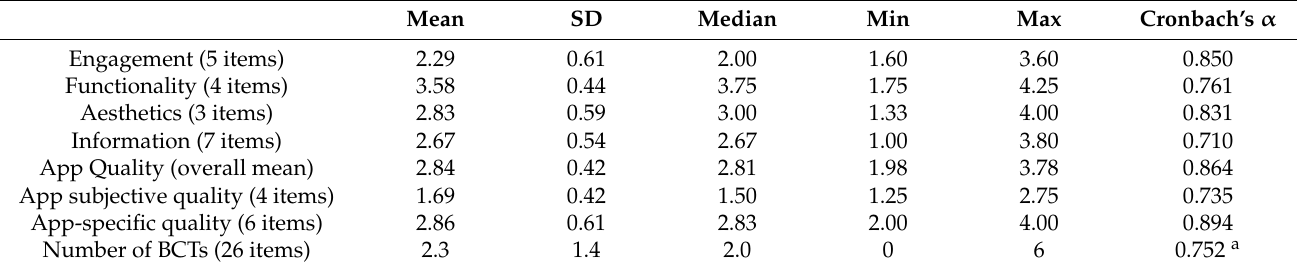
Table 1. App quality and behaviour change technique assessment scores.